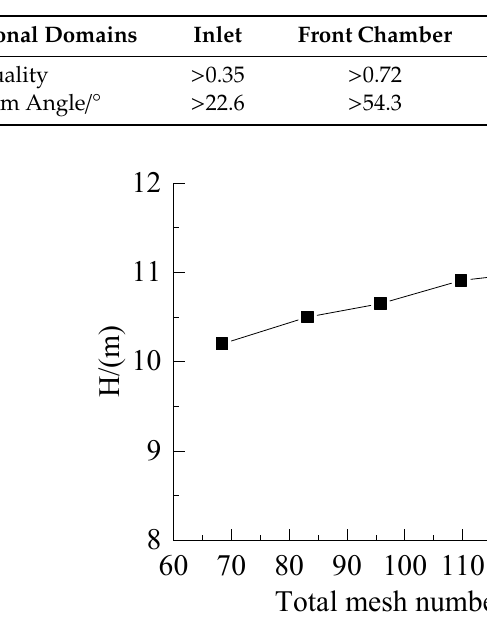
Figure 4. Structured mesh for the numerical domains. Table 4. Mesh information of the numerical domain.